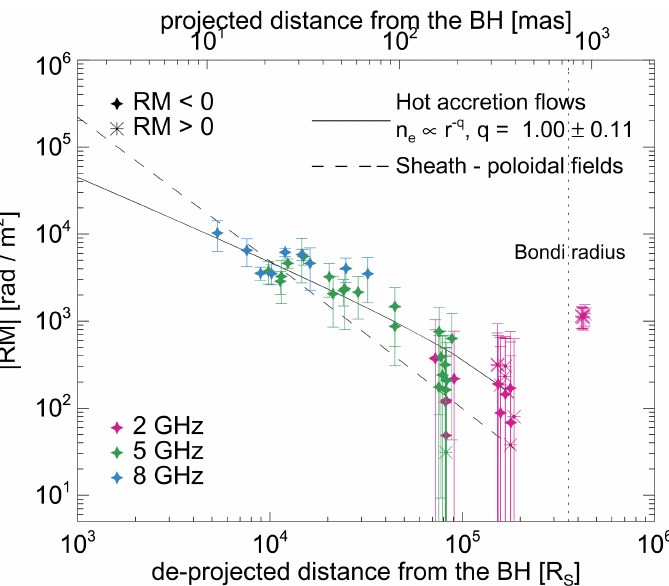
Figure 4. RM magnitudes of the M87 jet as functions of de-projected jet distance from the black hole in units of R S [81]. The data points obtained at different frequencies are shown in different colors. The diamonds and asterisks are negative and positive RMs, respectively. The vertical dotted line denotes the Bondi radius. The solid and dashed curves represent the best-fit hot accretion flows and jet sheath models, respectively. ©AAS. Reproduced with